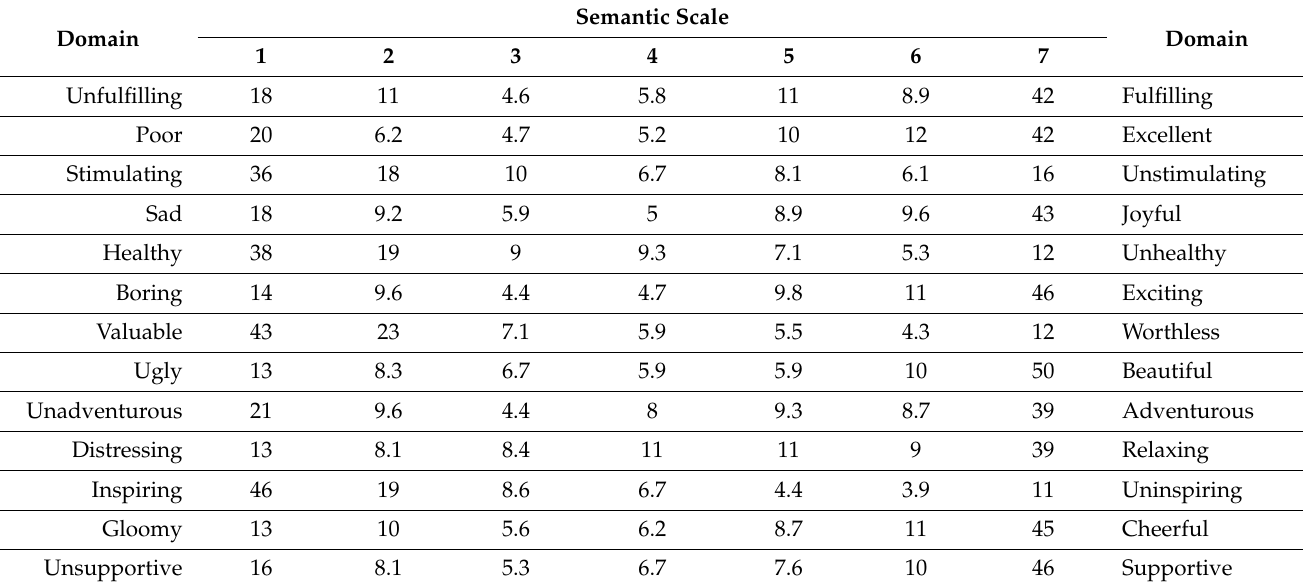
Table 3. The community images of PON XX.